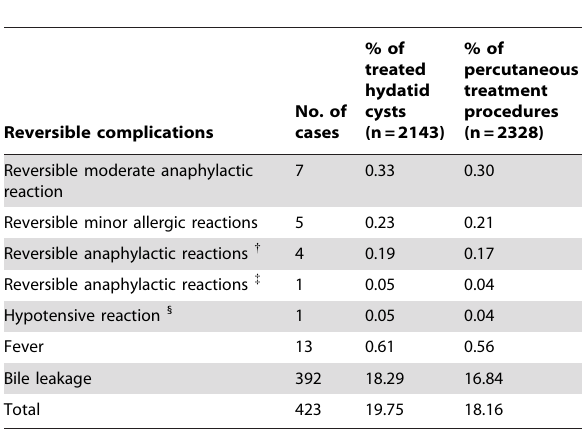
Table 4. Reversible complications due to percutaneous treatment of hydatid cysts of various